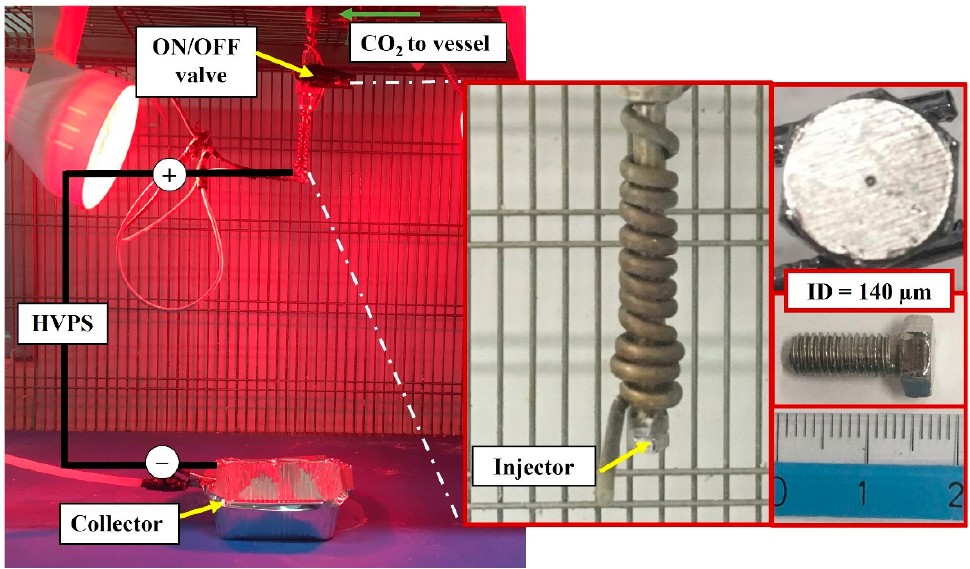
Figure 2. Real images of the spraying zone formed by the injector system elements and the collector used for nanoparticles deposit. The inset images show the detail of the injector used for these experiments.